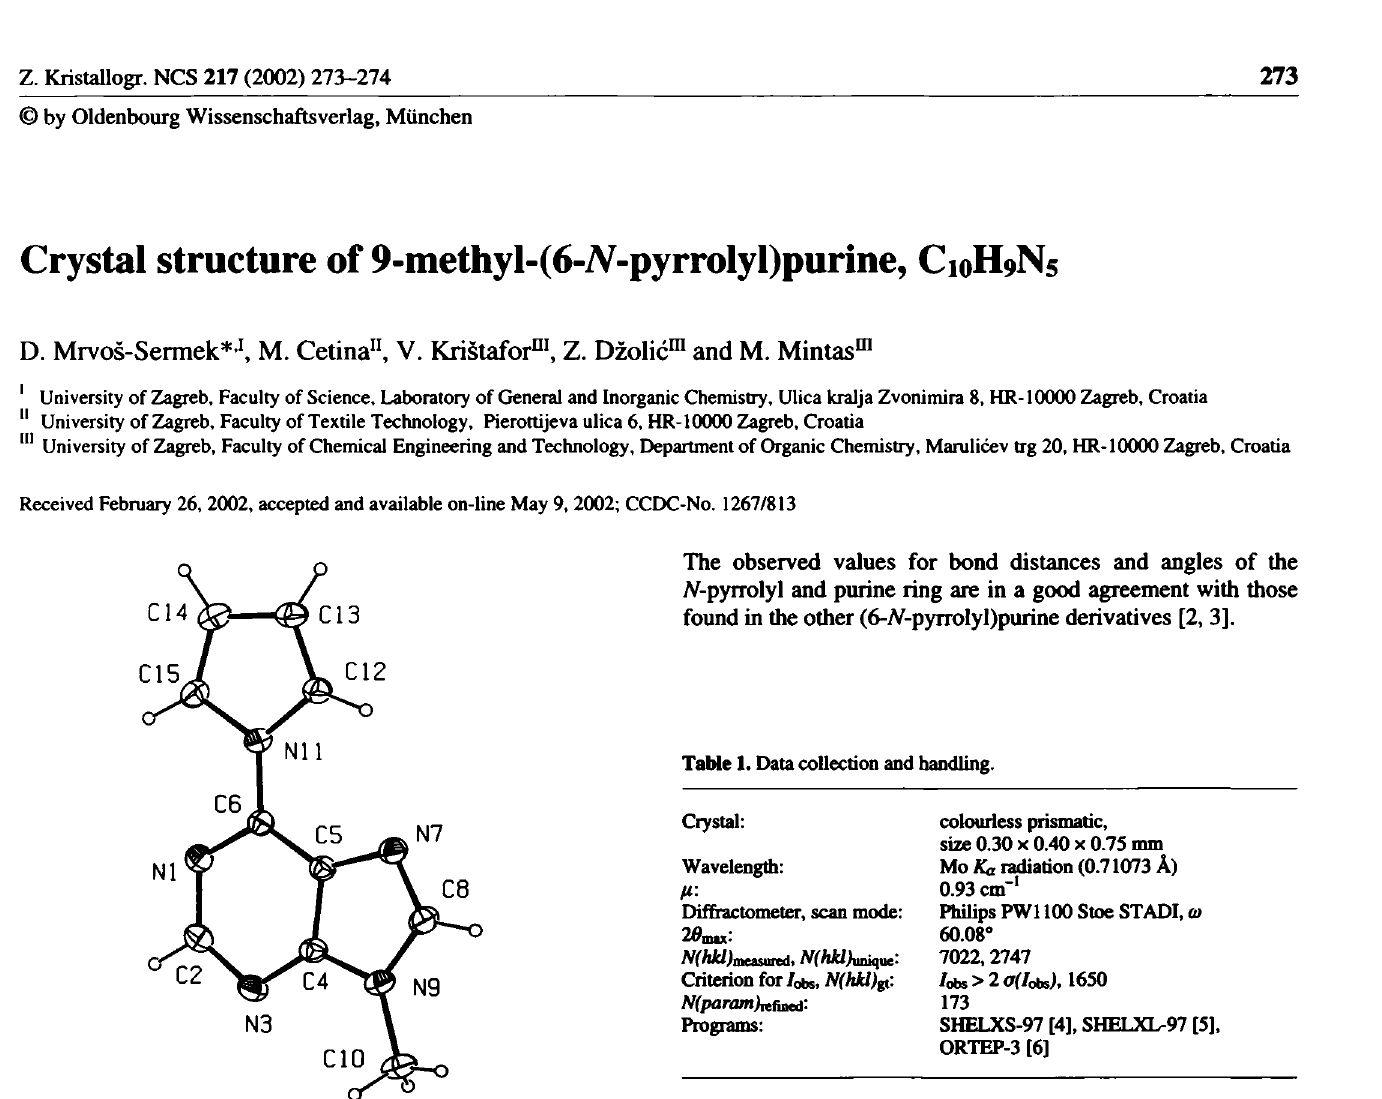
Table 2. Atomic coordinates and displacement parameters (in A 2